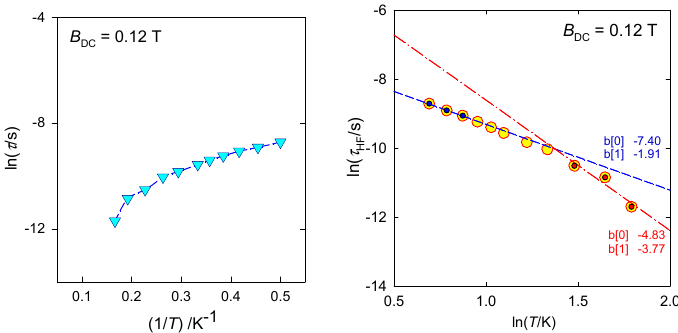
Figure 8. Temperature dependence of the relaxation time for the molecule.